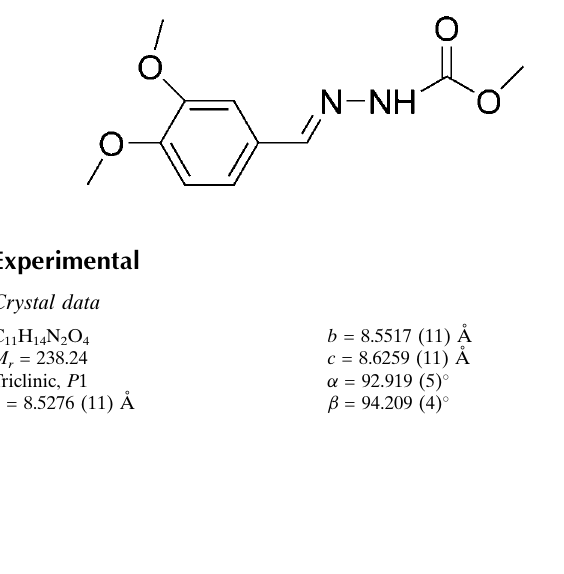
Related literature